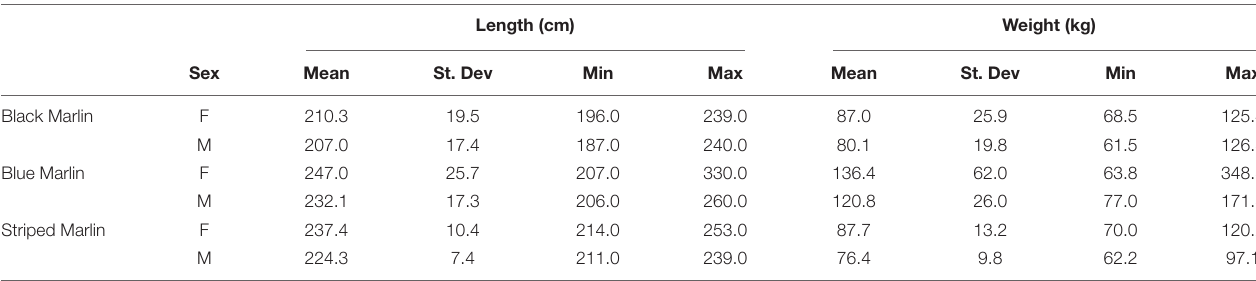
TABLE 2 | Mean size ( ± 1SD) and size range of male and female marlin of each of the three species sampled: black marlin ( Istiompax indica ), blue marlin ( Makaira nigricans ), and striped marlin ( Kajikia audax ). Length (cm) Weight (kg)